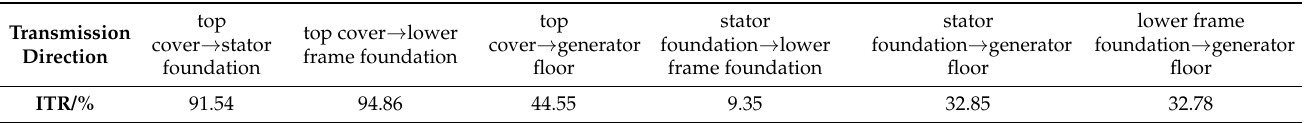
Table 4. Information-transmission rate between measurement points of condition 1.